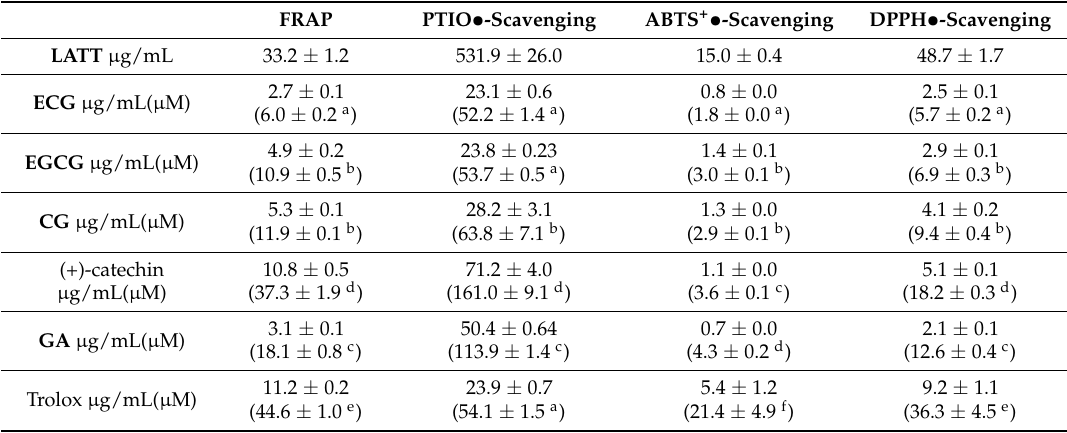
Table 1. The FRAP and SC 50 values of LATT, ECG, EGCG, CG, C, GA , and